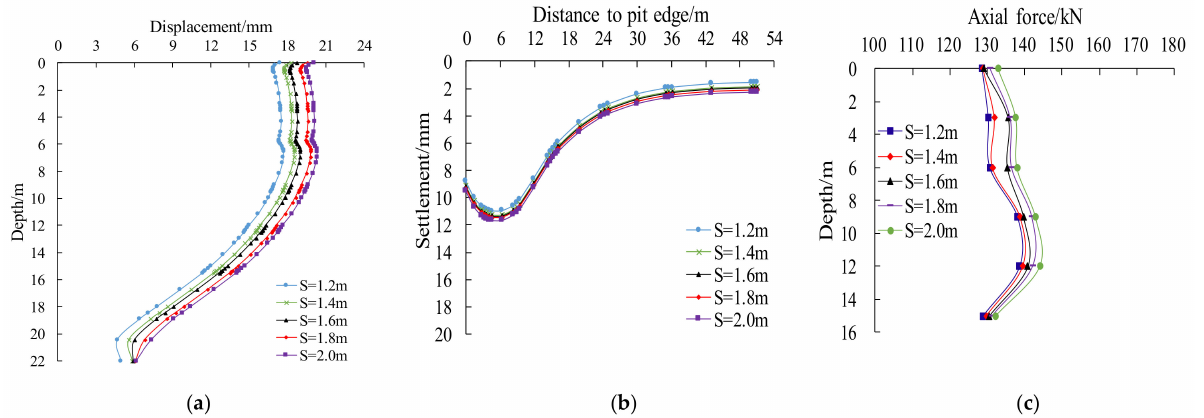
Figure 24. Influence curve of different pile spacing: ( a ) Horizontal displacement of piles, ( b ) Ground settlement, ( c ) Axial